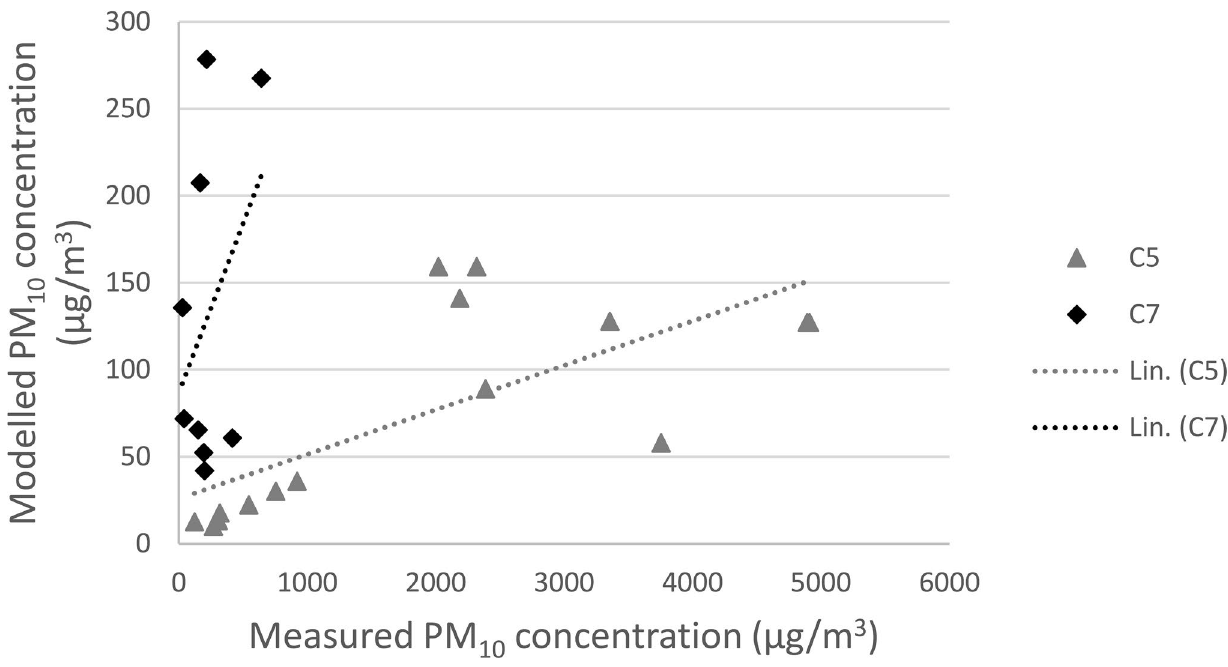
Fig. 8 Comparison of the modelled and measured PM according to US EPA [13]